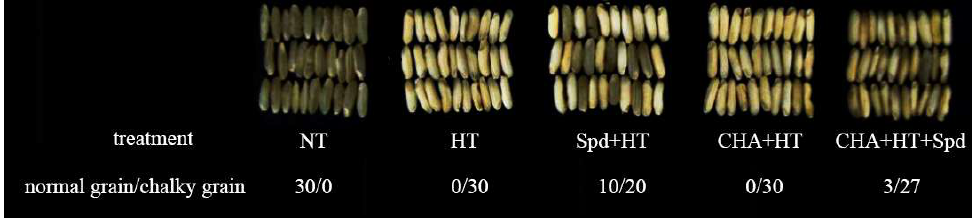
Figure 1. Effect of exogenous spermidine (Spd) and cyclohexylamine (CHA) on the ratio of chalky grains to normal grains of rice under high-temperature stress. NT: Normal temperature control; HT: High temperature control; Spd + HT: 1.5 mM exogenous Spd treatment + high temperature; CHA+HT: 20 mM exogenous CHA treatment + high temperature; CHA + HT + Spd: 20 mM exogenous CHA treatment + high temperature + exogenous 1.5 mM Spd.